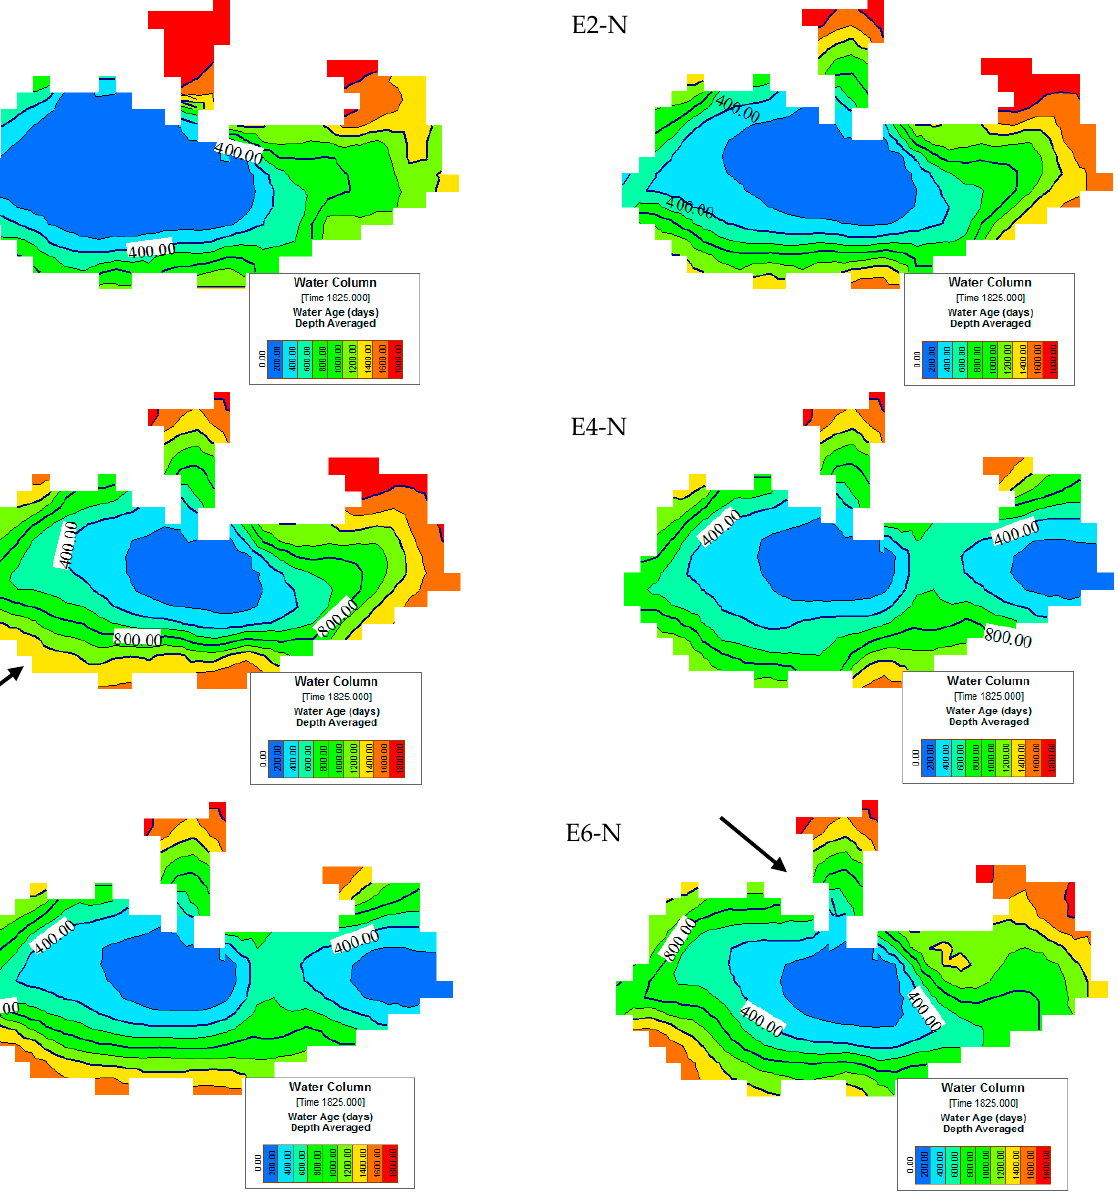
Figure 4. The water age distribution in the small lake after 5 years’ simulation under different scenarios (without considering farmland drainages, and the black arrows represent the schematic wind direction in the two comparing scenarios E3 and E6).